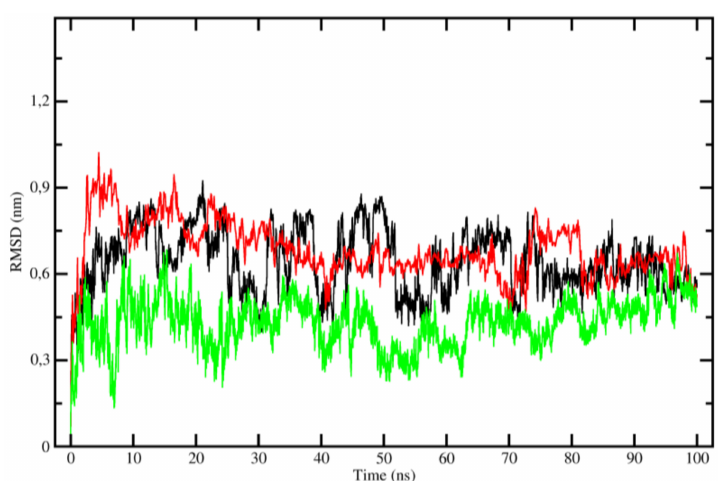
Figure A7. RMSD profile for C- α atoms over 100 ns from MD simulations. Stigmurin (black line), StigA25 (red line), and StigA31 (green